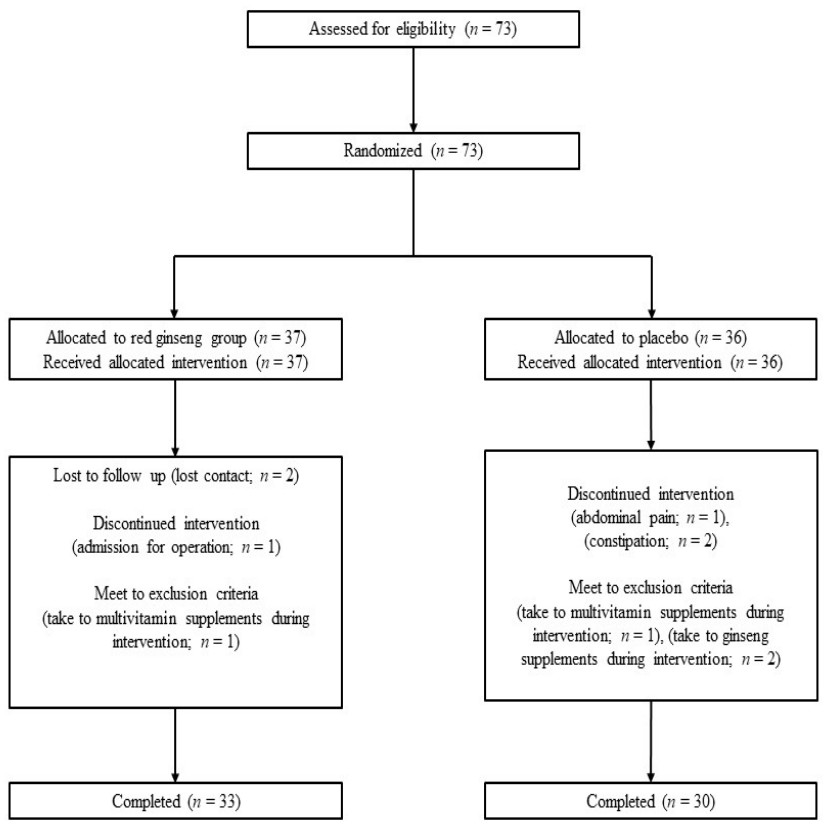
Figure 1. Flowchart of the study.